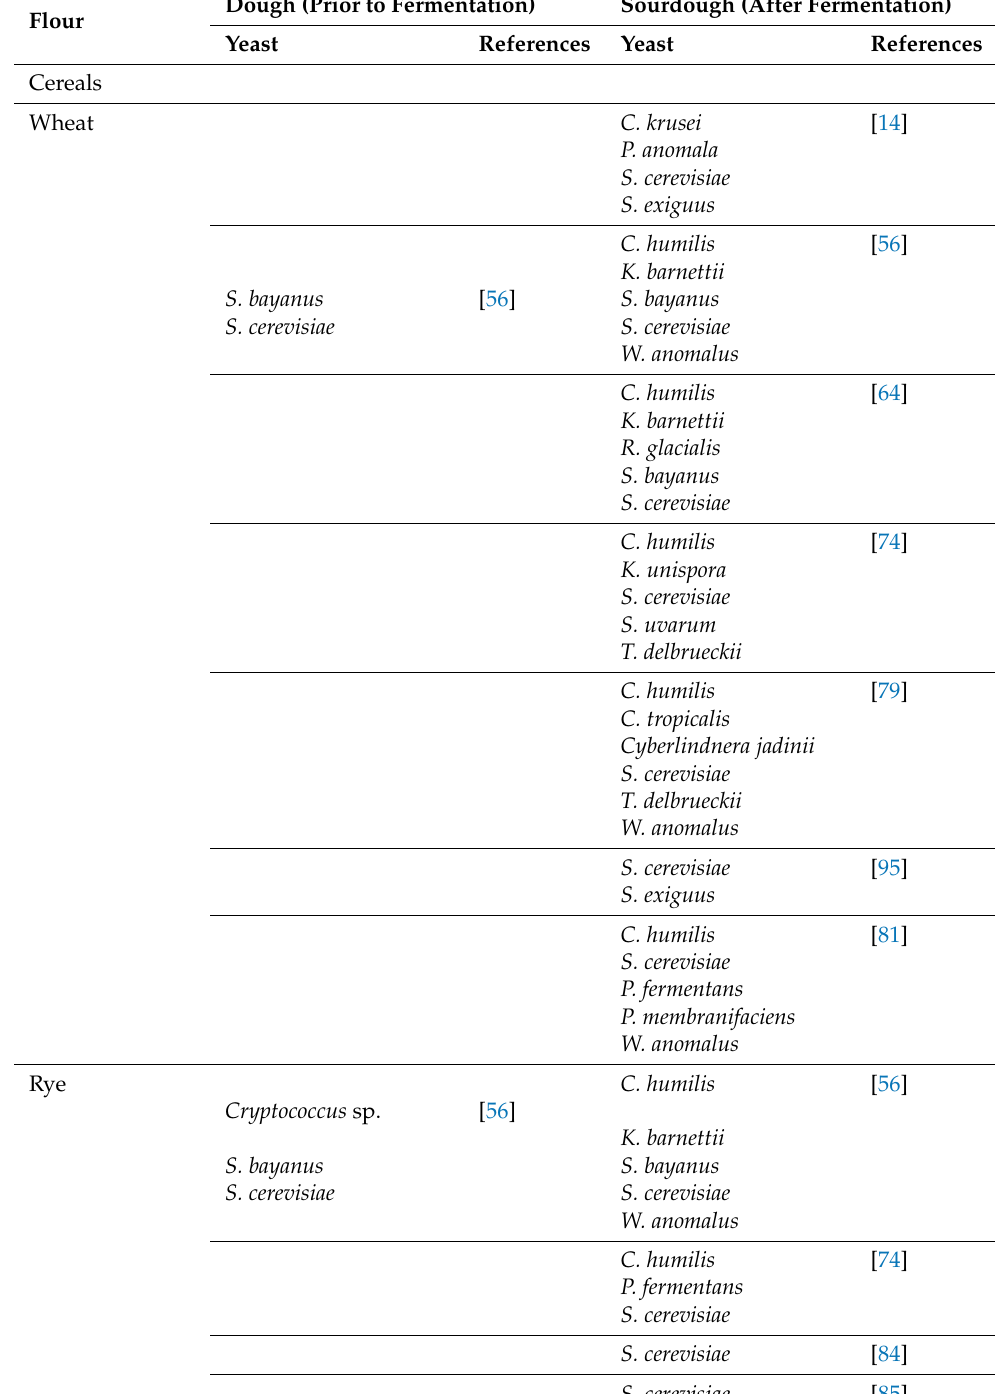
Table 3. Summary of yeasts isolated from sourdough using different types of flour.